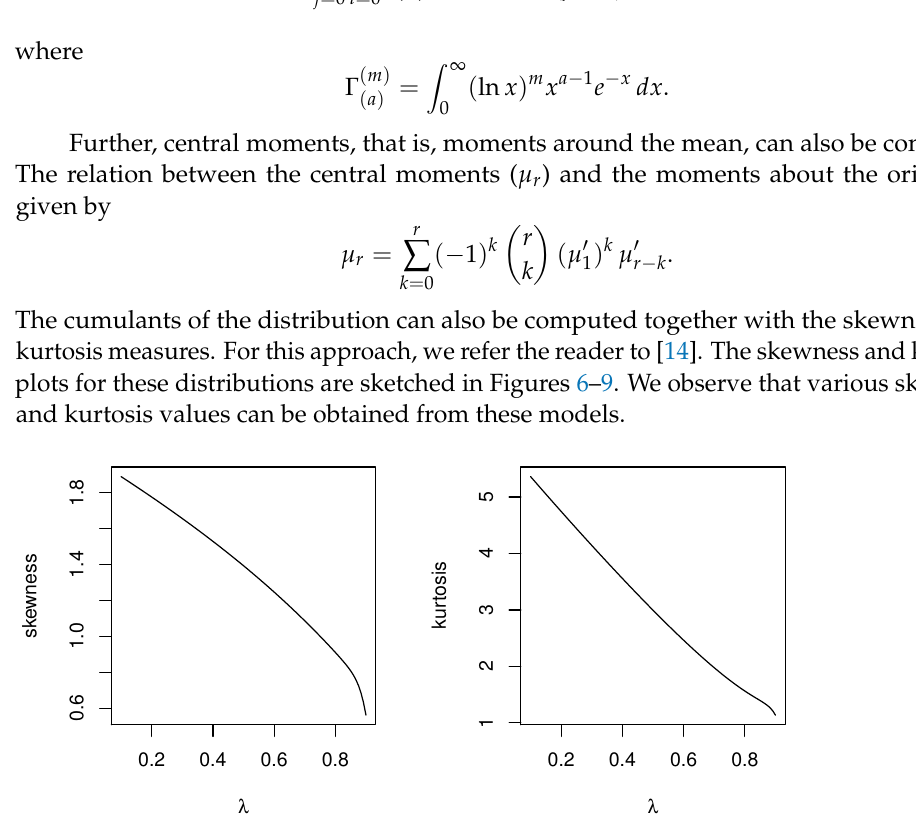
Figure 6. Skewness and kurtosis plots of the LiE1 distribution as a function of parameter λ